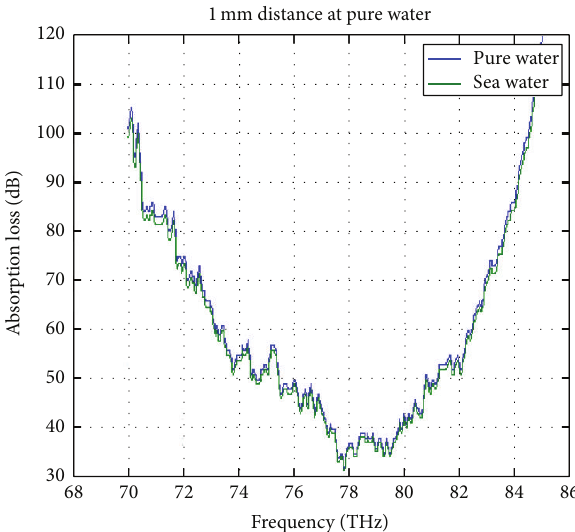
Figure 5: Absorption differences between pure water and 41% salinity sea water at 25 ∘ C.